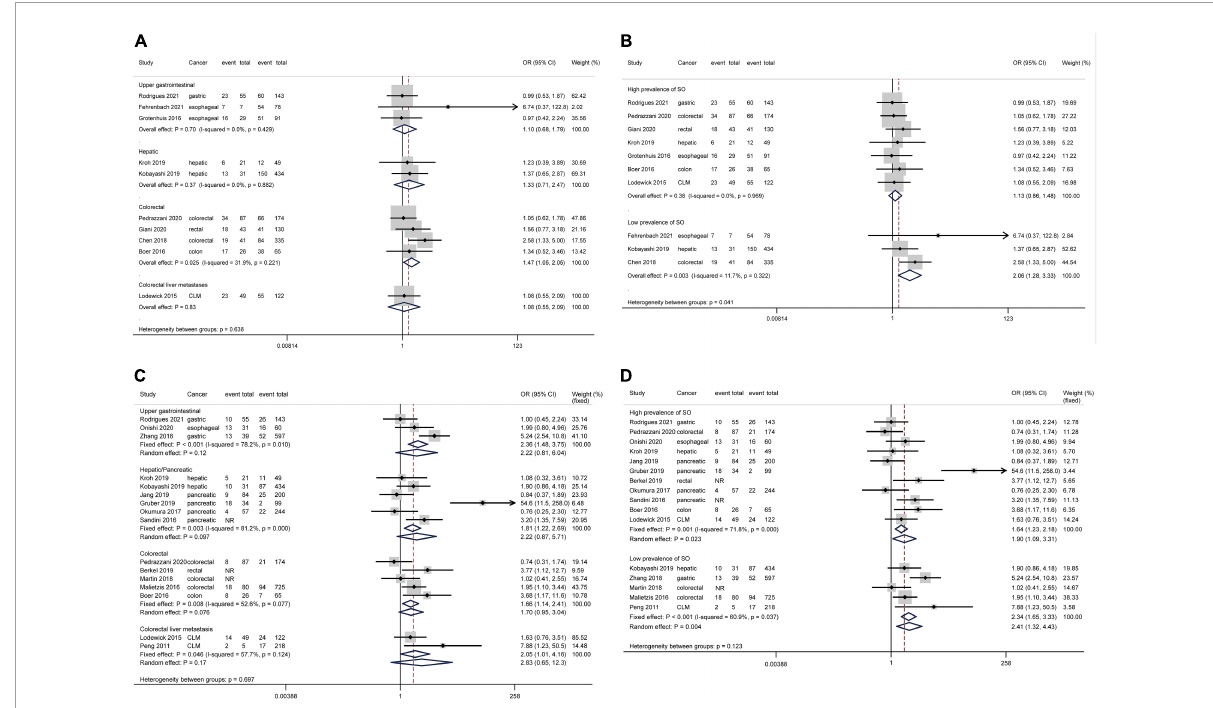
FIGURE3 Forest plots of subgroup analyses for sarcopenic obesity and postoperative complications stratified by cancer type and sarcopenic obesity prevalence. Total complications: (A,B) Major complications: (C,D) . CI, confidence interval; CLM, colorectal liver metastasis; OR, odds ratio; SO, sarcopenic